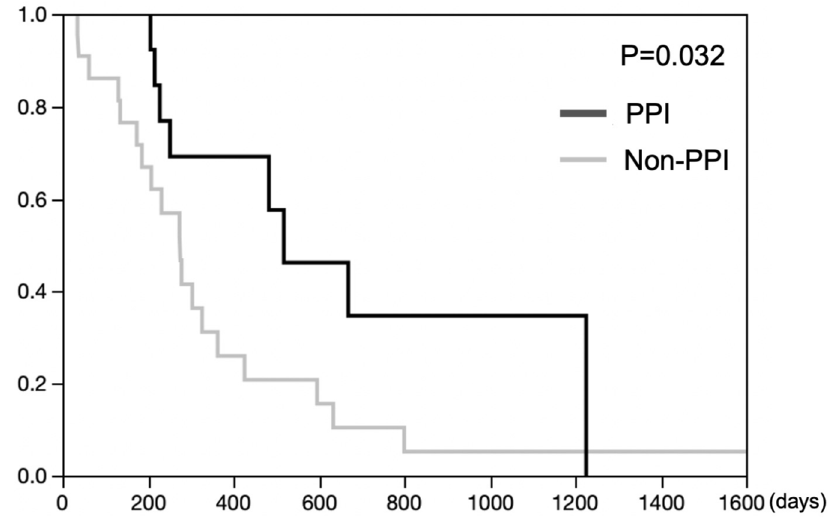
Figure 6. Overall survival (OS) according to PPI use or non-use in esophageal cancer patients receiving 5-FU-based chemotherapy.